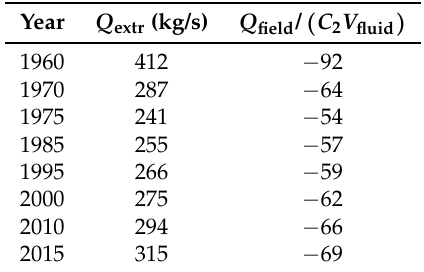
Table 2. Production history of the Larderello field from 1960 to 2015. Artificial re-injection started in 1975.